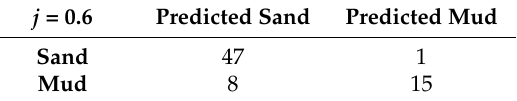
Table 7. Confusion matrix for classification from the second Neath flight using an ANN fed with HSV and NIR data channels. Calculated j values for the classification are also given in the upper left cell. j =